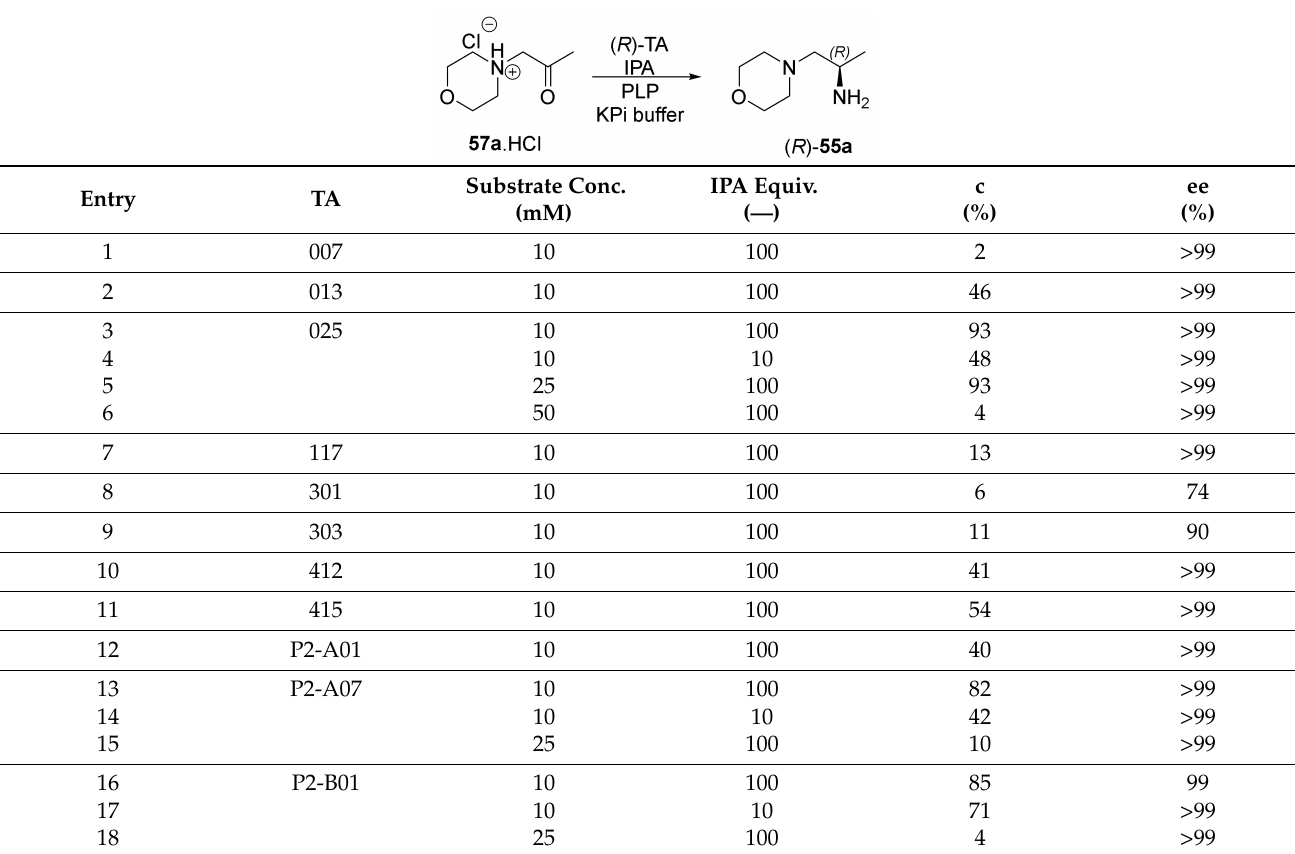
Table 2. Activity screening with the ( R )-selective TAs of the Codex ® Amine Transaminase Screening Kit in transamination of 1-morpholinopropan-2-one ( 57a